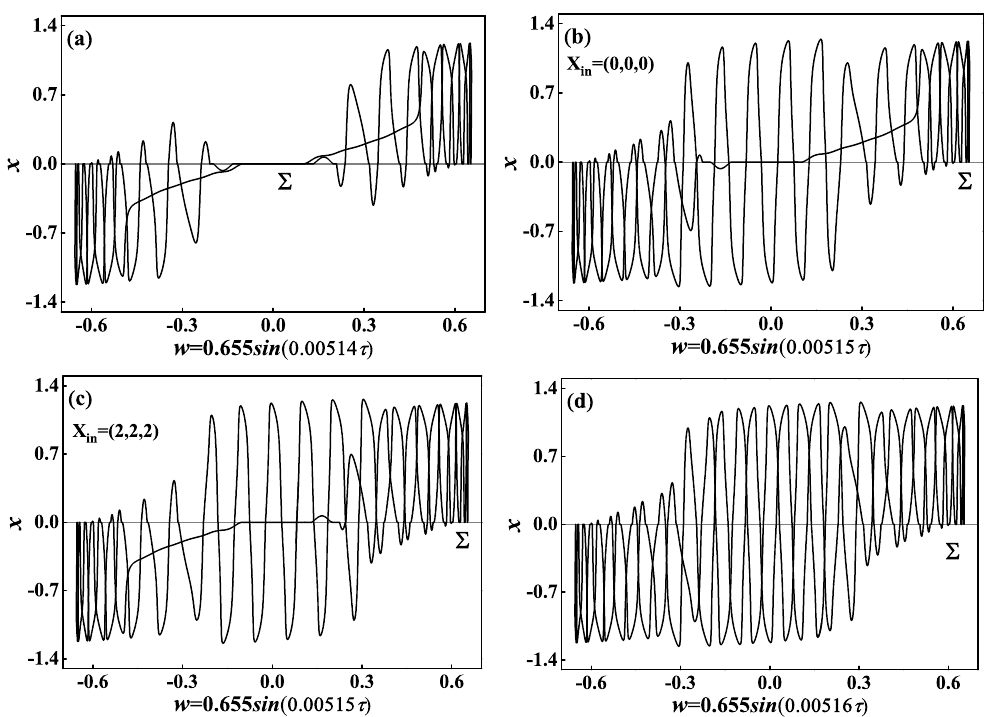
Figure 8. Transformed phase portraits of the four period-1 solutions: ( a ) symmetrical bursting oscilla- tion with Ω = 0.00514; ( b , c ) are the two coexisting periodic bursting oscillation with Ω = 0.00515; ( d ) non-bursting period-1 solution with Ω =